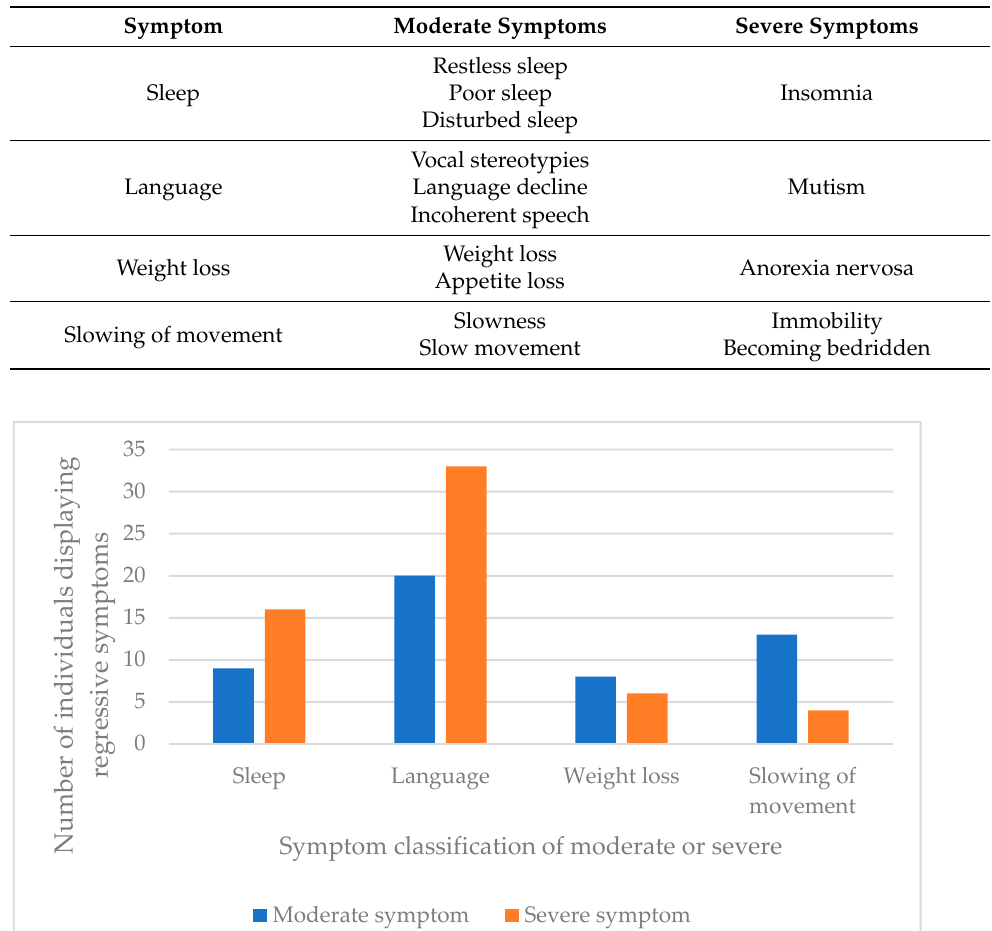
Table 3. Descriptive terminology used in articles reviewed. Four of the symptoms identified from the case study data (Group A patients) were able to be analysed. Reviewer determined categorisation of “moderate” or “severe” impact.